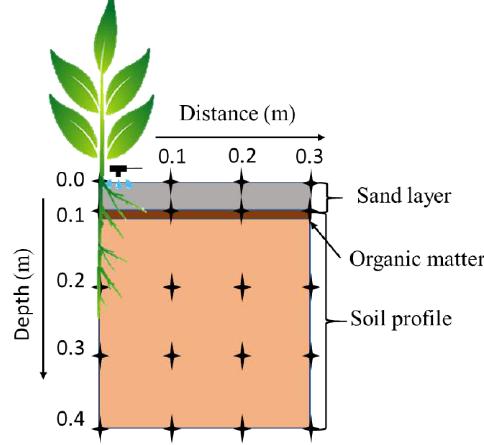
Figure 1. Sampling